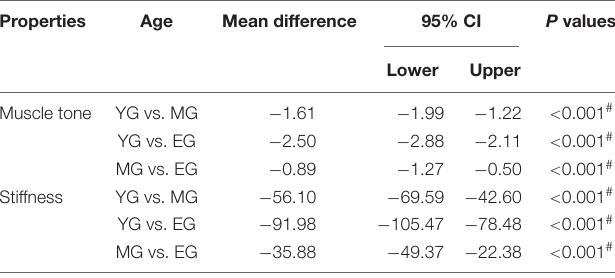
TABLE 4 | Statistical results of post hoc analysis.